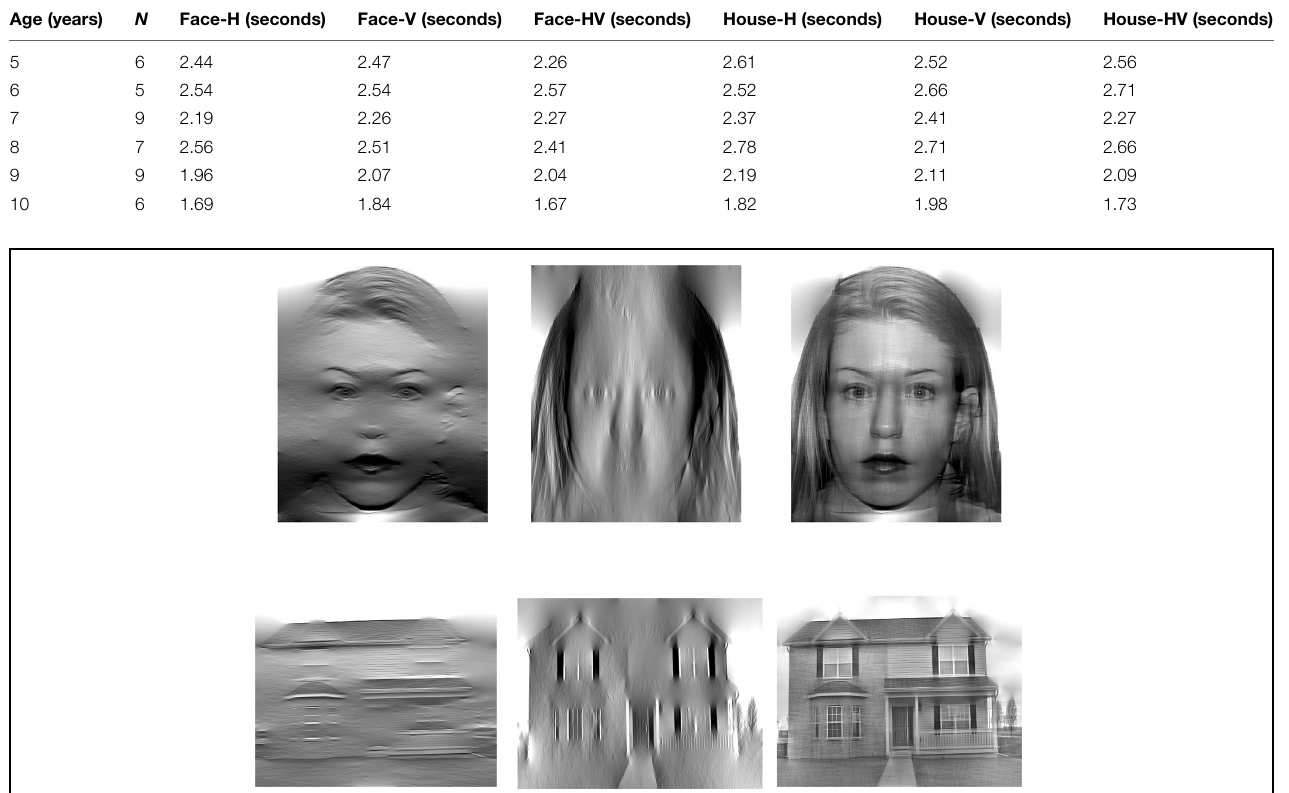
FIGURE 1 | Examples of faces and houses with bandpass orientation filters applied to limit the orientation energy to horizontal and vertical bands, as well as a combination of both orientation passbands.